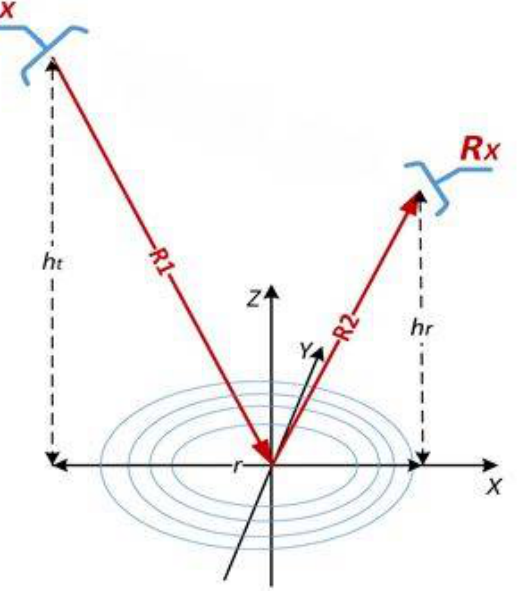
Figure 9. Geometry of GNSS-R for the coherent and incoherent models.